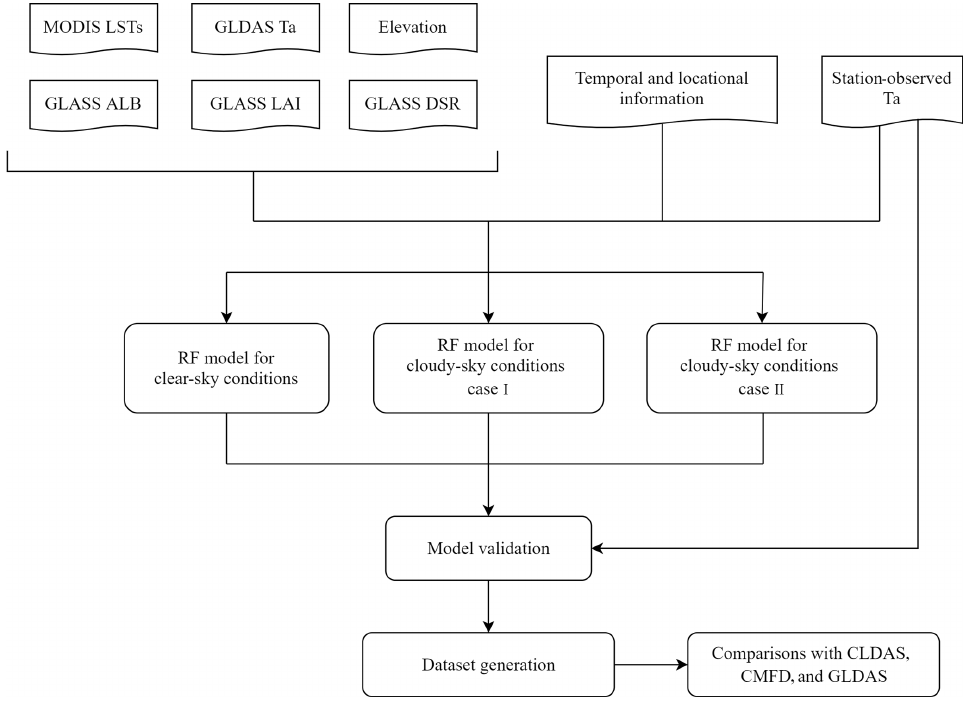
Figure 2. The overall framework of this study.